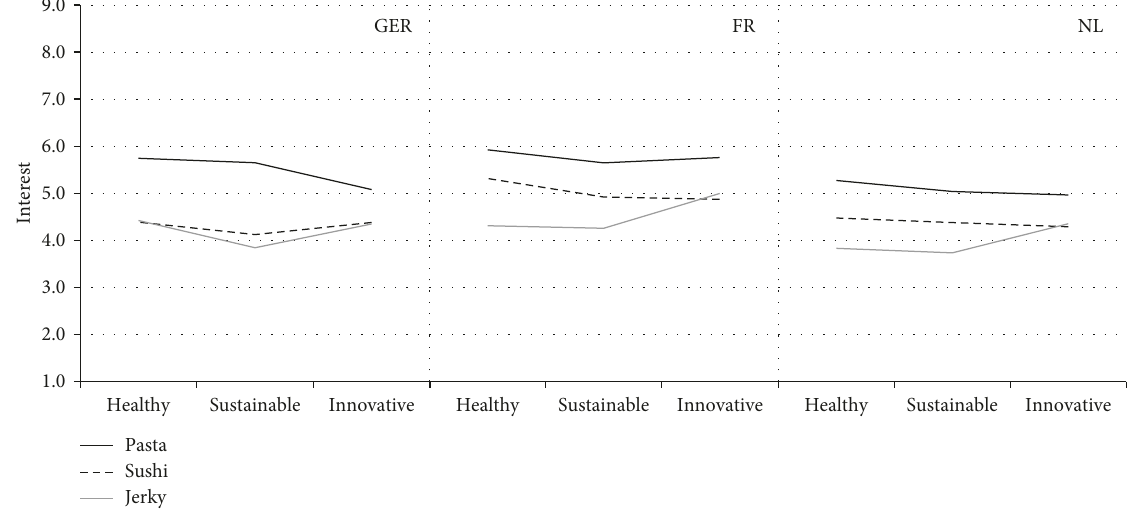
Figure 6: Interest (9-point scale (“not at all interesting” (1) to “very interesting” (9))) as a function of product, benefit, and country (marginal means from